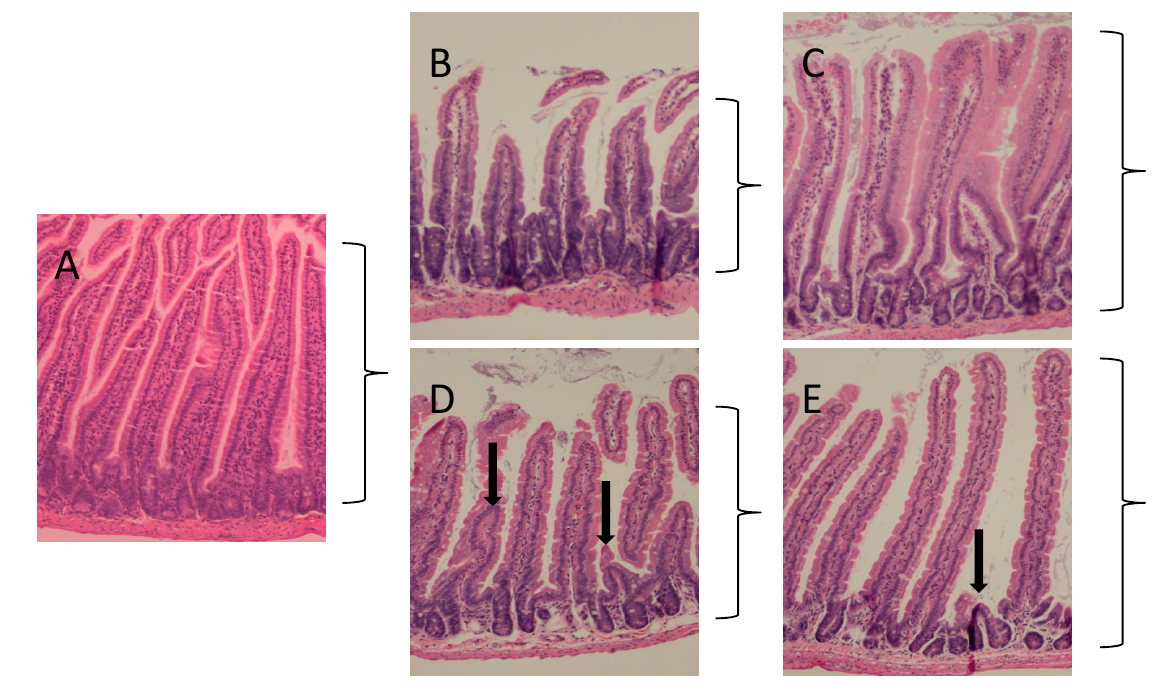
Figure 3. Effects of opaganib and radiation on the morphology of the small intestine. C57BL/6 mice were treated with 0 or 100 mg/kg opaganib orally 2 h before exposure to 9.5 Gy radiation. Control mice did not receive opaganib or radiation. Animals were then sacrificed on Day 4 or 10, and the small intestines were sectioned and stained with H&E. Representative sections are shown. Panel ( A ): unirradiated control, Panel ( B ): vehicle treated at 4 days, Panel ( C ): opaganib-treated at 4 days, Panel ( D ): vehicle treated at 10 days and Panel ( E ): opaganib-treated at 10 days. Villus height is indicated by the brackets and arrows indicate crypt destruction.